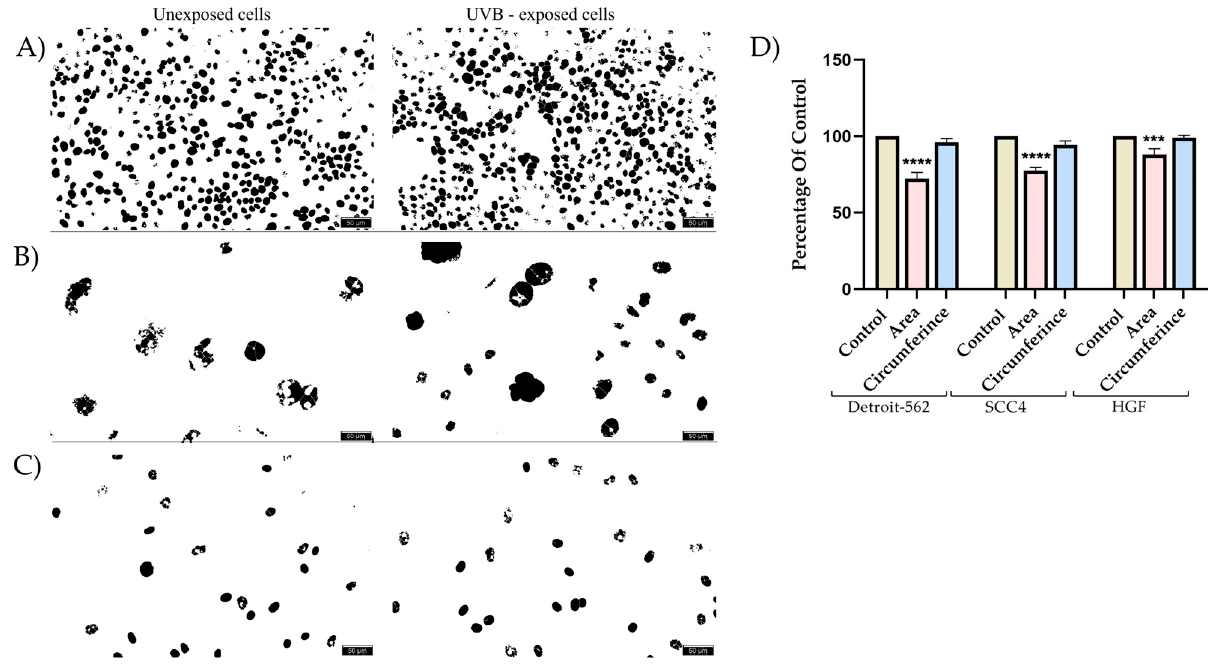
Figure 7. Evaluation of cell nuclei of ( A ) Detroit-562, ( B ) SCC4, and ( C ) HGF cells, after conversion to 8-bit images and application of the make-binary function. ( D ) As compared to the control cells, the cells exposed to UVB (2.5 J/cm 2 ) showed a decrease in their nuclear area as well as their nuclear circumferences. The statistical differences between control and exposed cells were verified by applying one-way ANOVA analysis, followed by Dunnett’s multiple comparison post hoc test (*** p < 0.001; **** p <